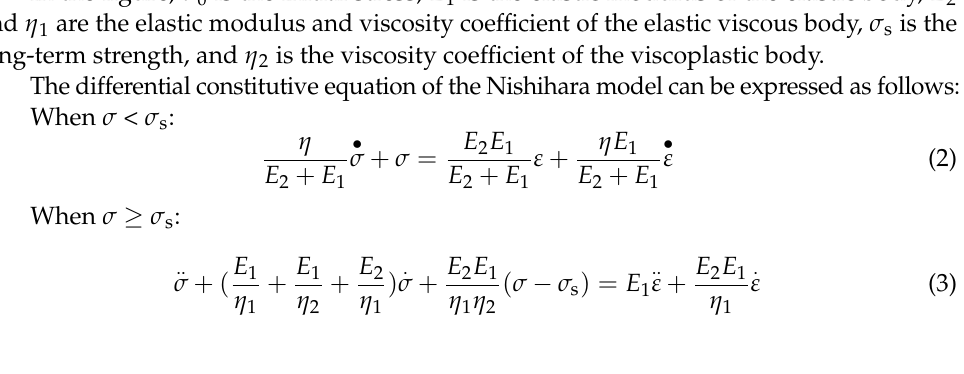
Figure 8. Nishihara model.